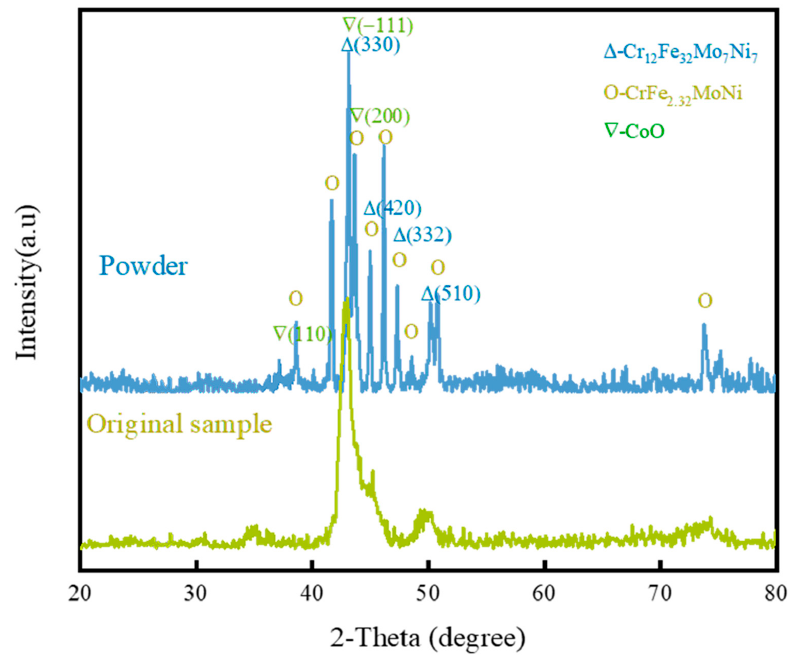
Crystals 2022 , 12 , x FOR PEER REVIEW Figure 2. Surface XRD patterns for the FeCoNiCrMo powder and the FeCoNiCrMo coatings.